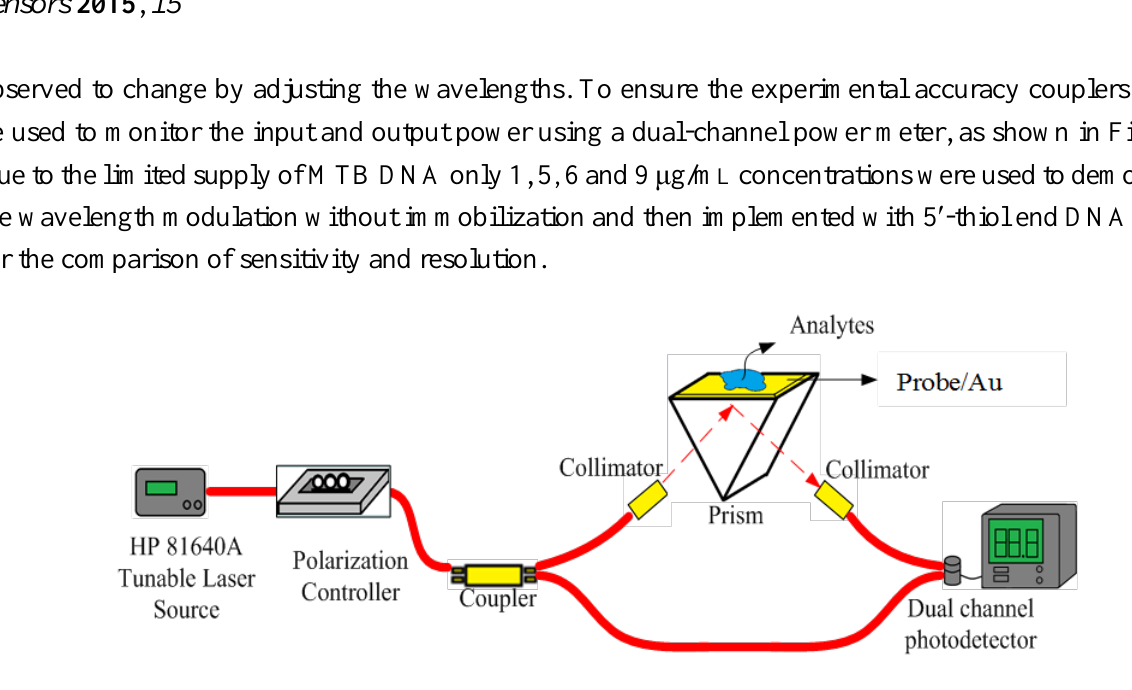
Figure 1. The fiber based testing setup for SPR wavelength